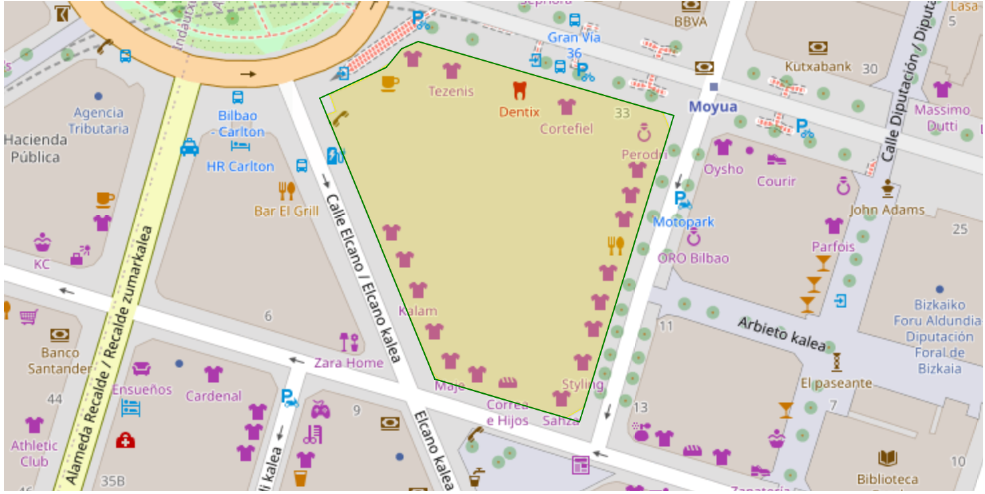
Figure 14. The edges of the building in green.